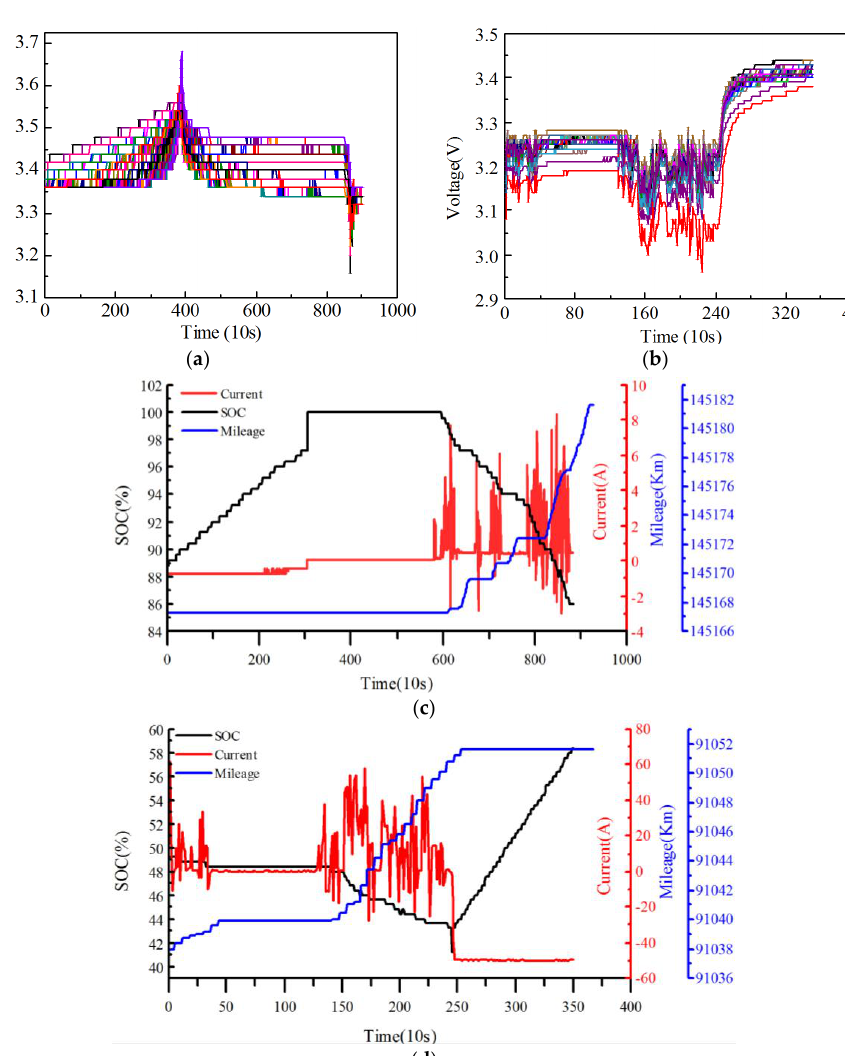
Figure 5. ( a ) The voltage curve of Vehicle 1; ( b ) The voltage curve of Vehicle 2; ( c ) The curves of current, state of charge (SOC) and mileage of Vehicle 1; ( d ) The curves of current, SOC and mileage of Vehicle 2.